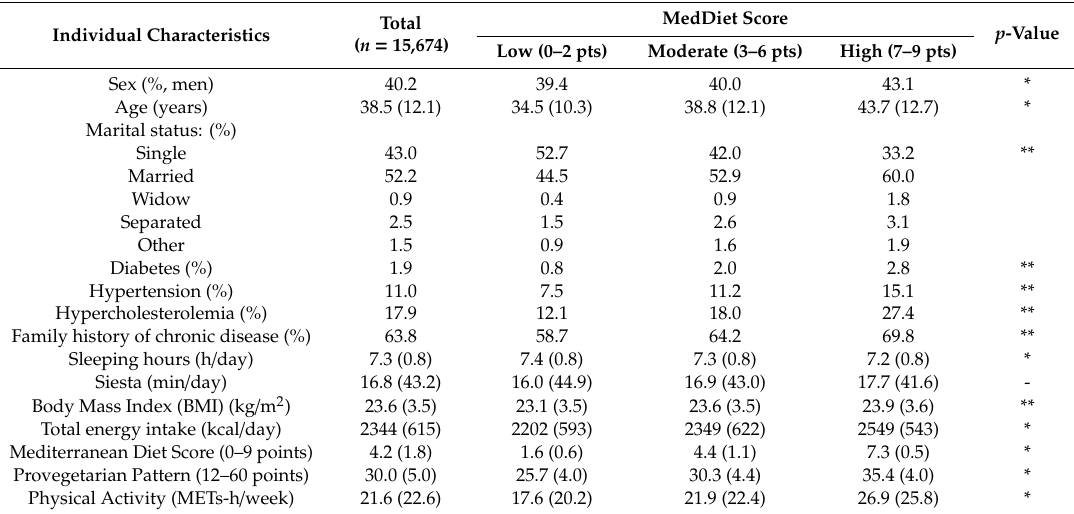
Table 1. Demographic and lifestyle characteristics of the total sample and as categories of the MedDiet score: The Seguimiento Universidad de Navarra (SUN) Study (2019).